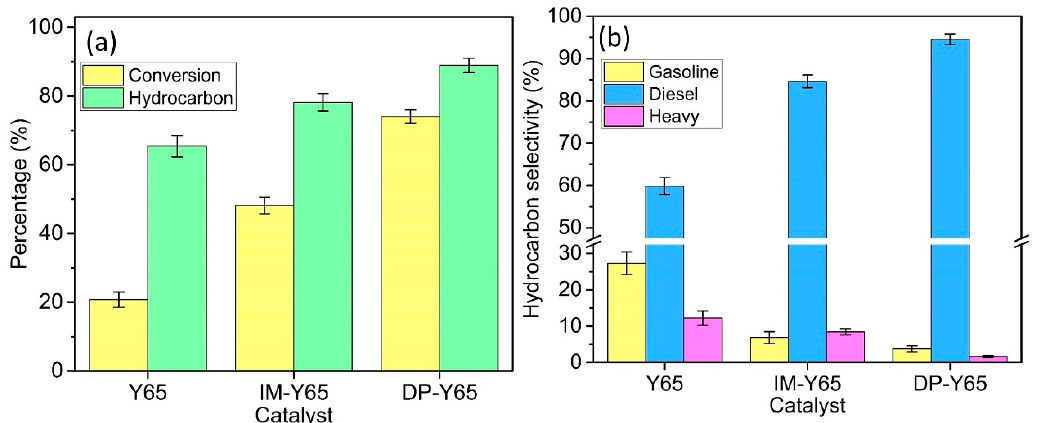
Figure 5. ( a ) Comparison study of conversion and hydrocarbon product and ( b ) hydrocarbon selectivity from deoxygenation of triolein over synthesized